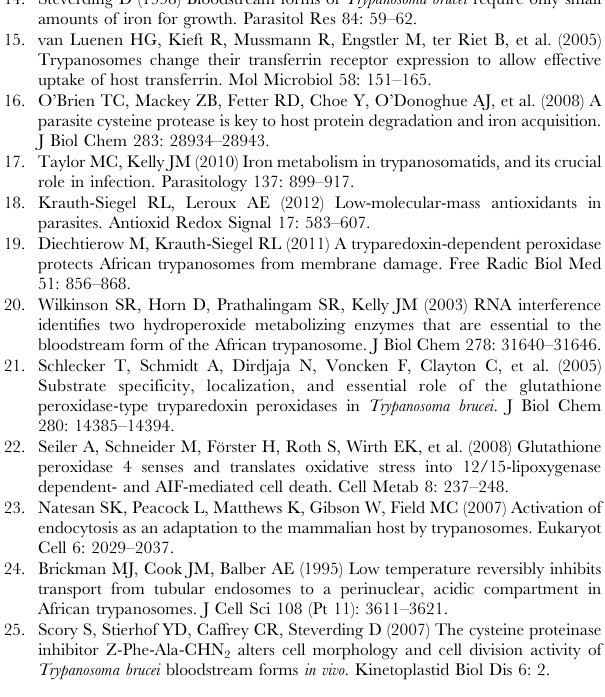
Figure S5 Western blot analysis of transferrin-depleted medium. Commercial holo-TF (100 ng) and 0.5 m l of the standard medium (corresponding to 100 ng TF) as well as of the fractions collected from the anti-TF column were subjected to Western blot analysis using the polyclonal antibodies against bovine TF. Fraction 1 was the FCS-free medium used for equilibration (not shown), fractions 2 to 4 represented TF-free medium whereas in fractions 5 and 6, TF was again detectable. Table S1 Primers used for the PCR analysis of px I–II 2 / 2 procyclic cells.